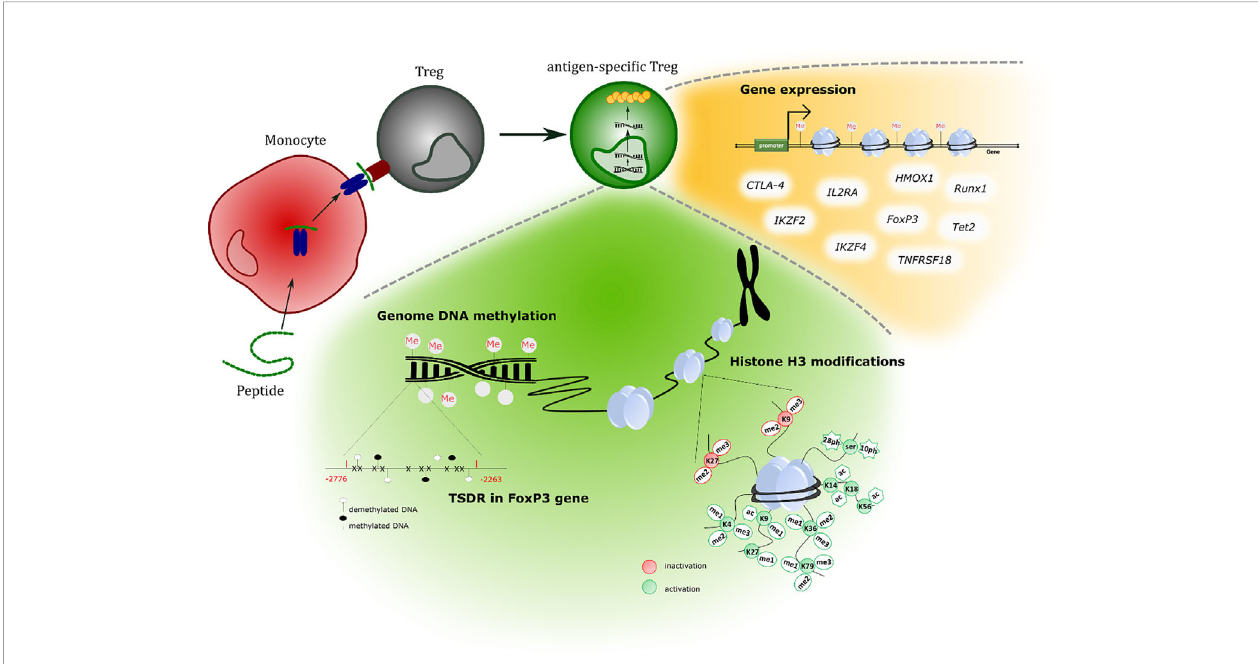
FIGURE 1 | An overview of tests performed to study epigenetic features of generated